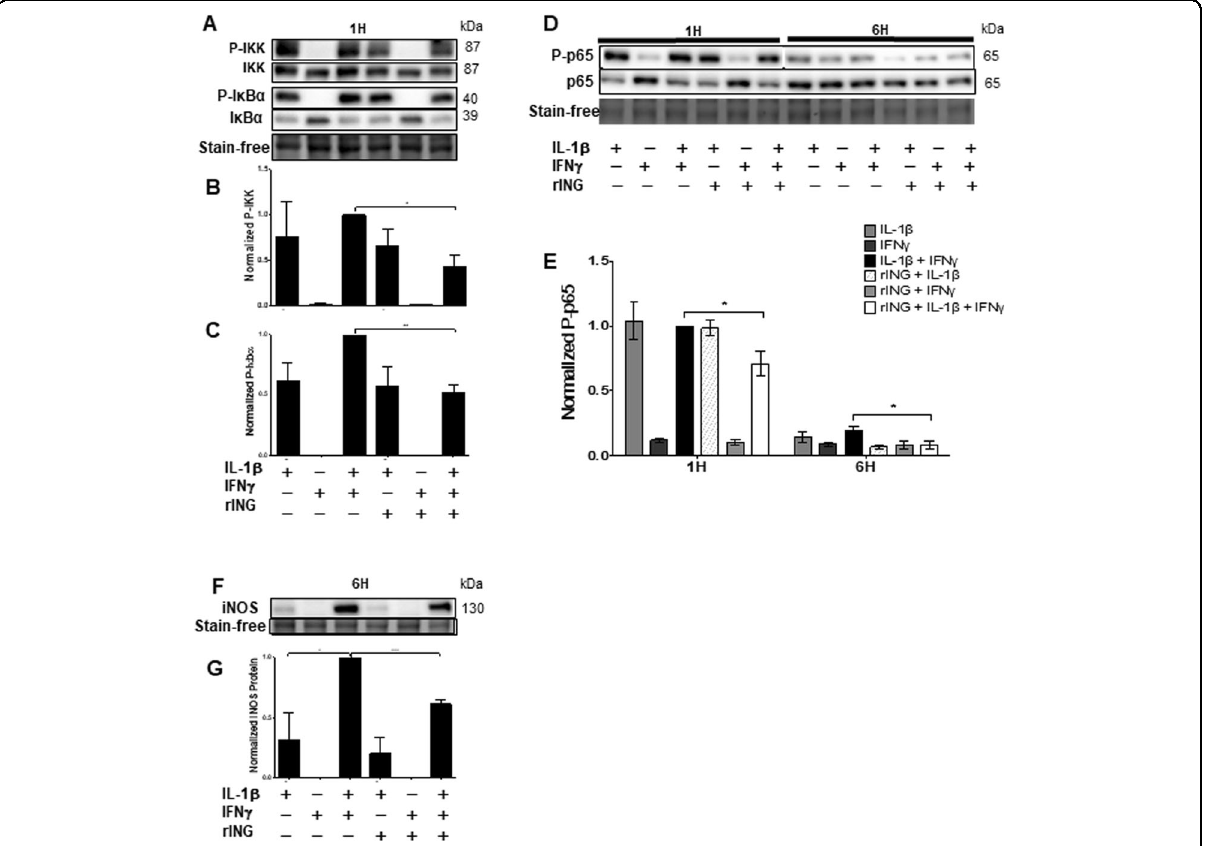
Fig. 5 rINGAP pre-treatment inhibits NF- κ B signaling when IL-1 β and IFN γ used together but not individually. RINm5F cells were pre-treated with 1 nM rINGAP for 2 h and then exposed to 100 pg/mL IL-1 β , 1 ng/mL IFN γ , or a cocktail of both. Equal amounts of protein were resolved on stain- free SDS-PAGE and analyzed by Western blot to assess changes in: A phospho(P)-IKK, and phospho(P)-I κ B α , with densitometric analysis shown in B and C , respectively; D , E phospo(P)-p65 and F , G iNOS. Shown are representative blots from three independent experiments. Densitometric data in B , C and E are presented as relative quantities of phosphorylated/total protein ratio normalized to total lane protein and expressed as fold change of cytokine cocktail. G Values for iNOS were normalized by total lane protein and are shown as fold change of cytokines. Data expressed as means ± SEM * P < 0.05, ** p < 0.01, *** p < 0.001 vs time-matched cytokine cocktail; multiple t test comparisons corrected by the Sidak – Bonferroni